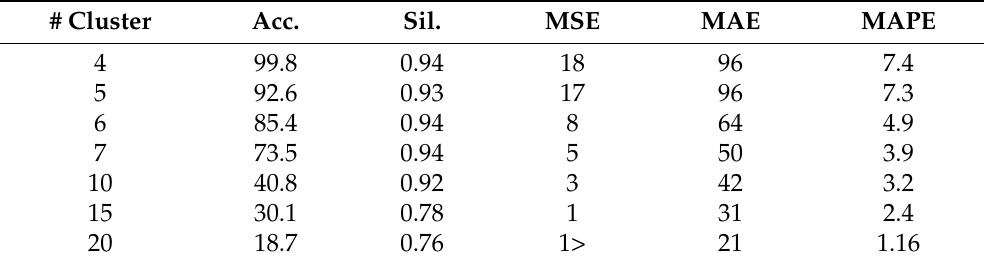
Table 4. Prediction efficiency in function of the number of